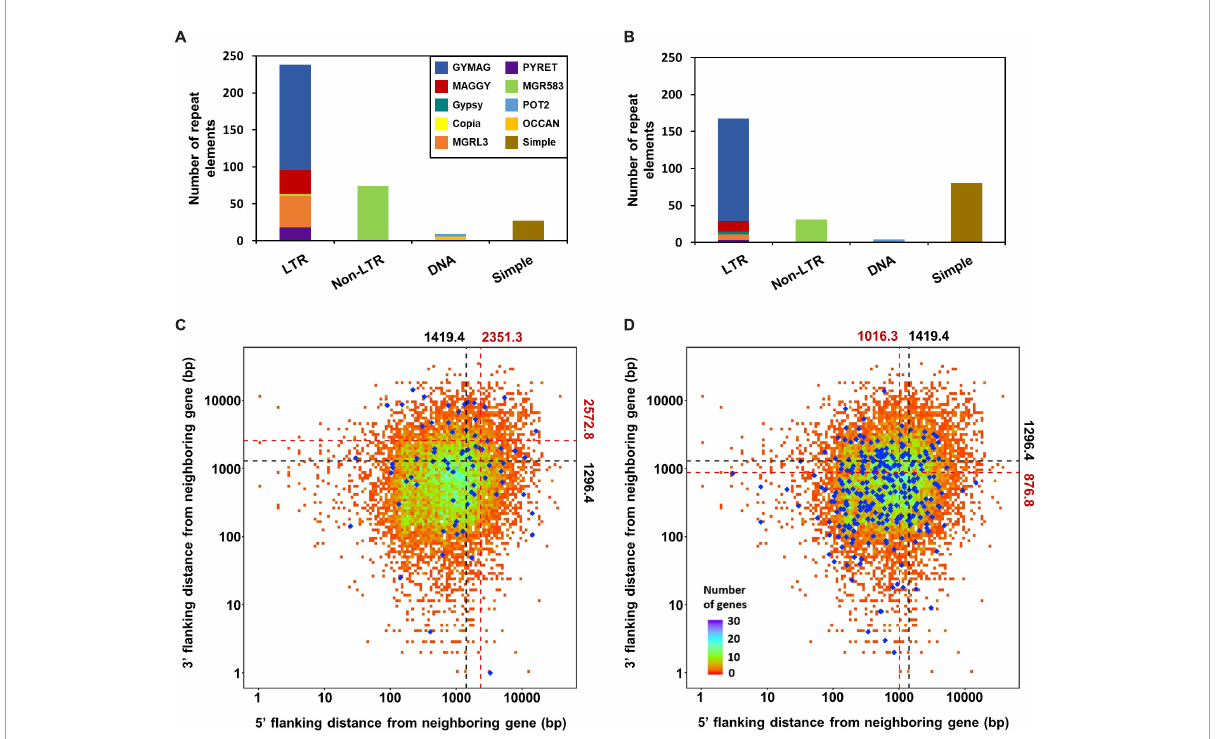
FIGURE3 Relationship between sRNA loci and repeat elements. Repeat elements associated with (A) Dicer-dependent and (B) Dicer-independent sRNA loci. Nearest-neighbor gene distance density plot for genes associated with (C) Dicer-dependent, and (D) Dicer-independent sRNA loci. Total protein-coding genes are plotted as the background; blue diamonds, genes associated with sRNA loci. Average distances are shown above and on the right, and are plotted as dotted lines. Black and red, total protein-coding genes and genes with sRNA loci,